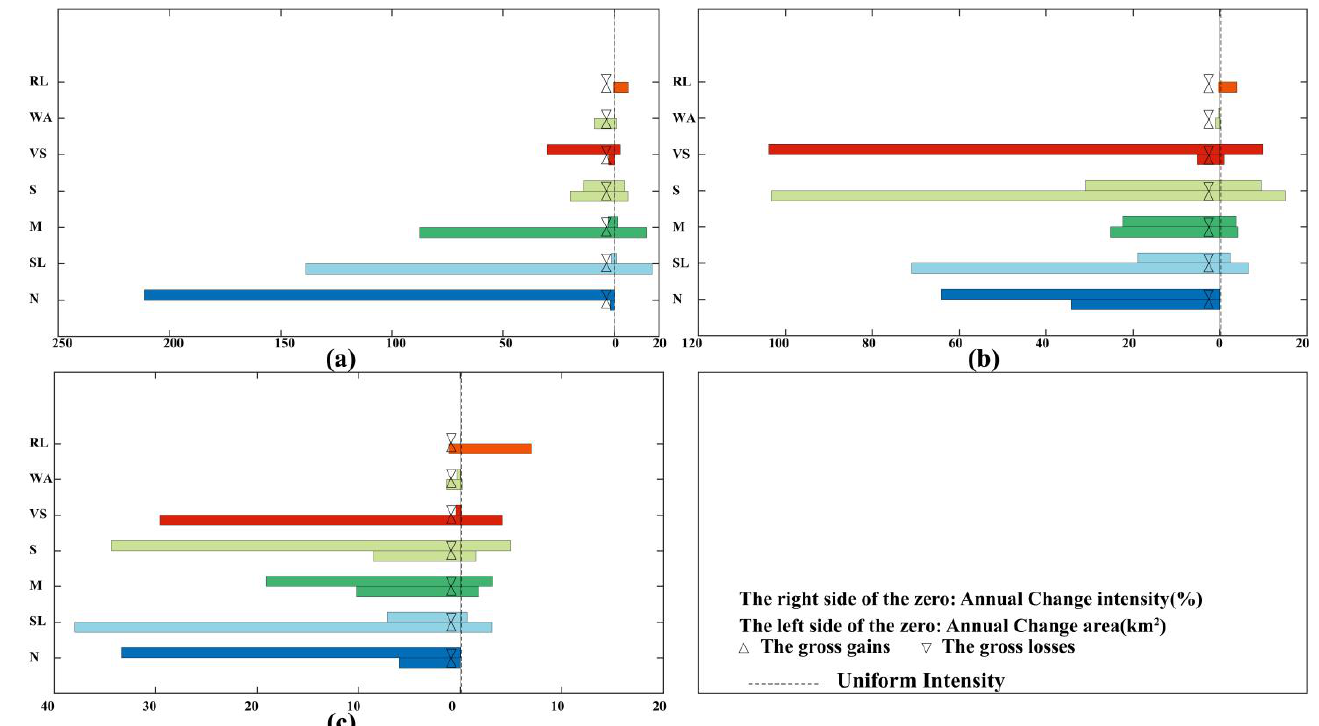
Figure 6. Area and intensity changes for different types of land in the three counties of Mongolia. ( a ) The interval of 2000~2005; ( b ) the interval of 2005~2010; ( c ) the interval of 2010~2015.